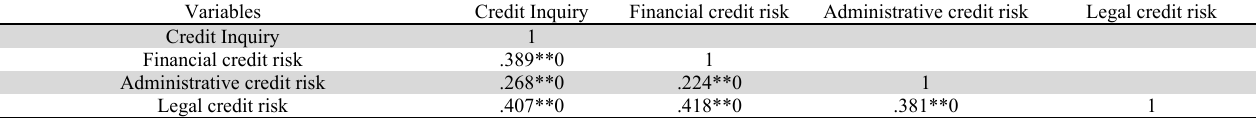
Matrix of correlation coefficients between variables in the study